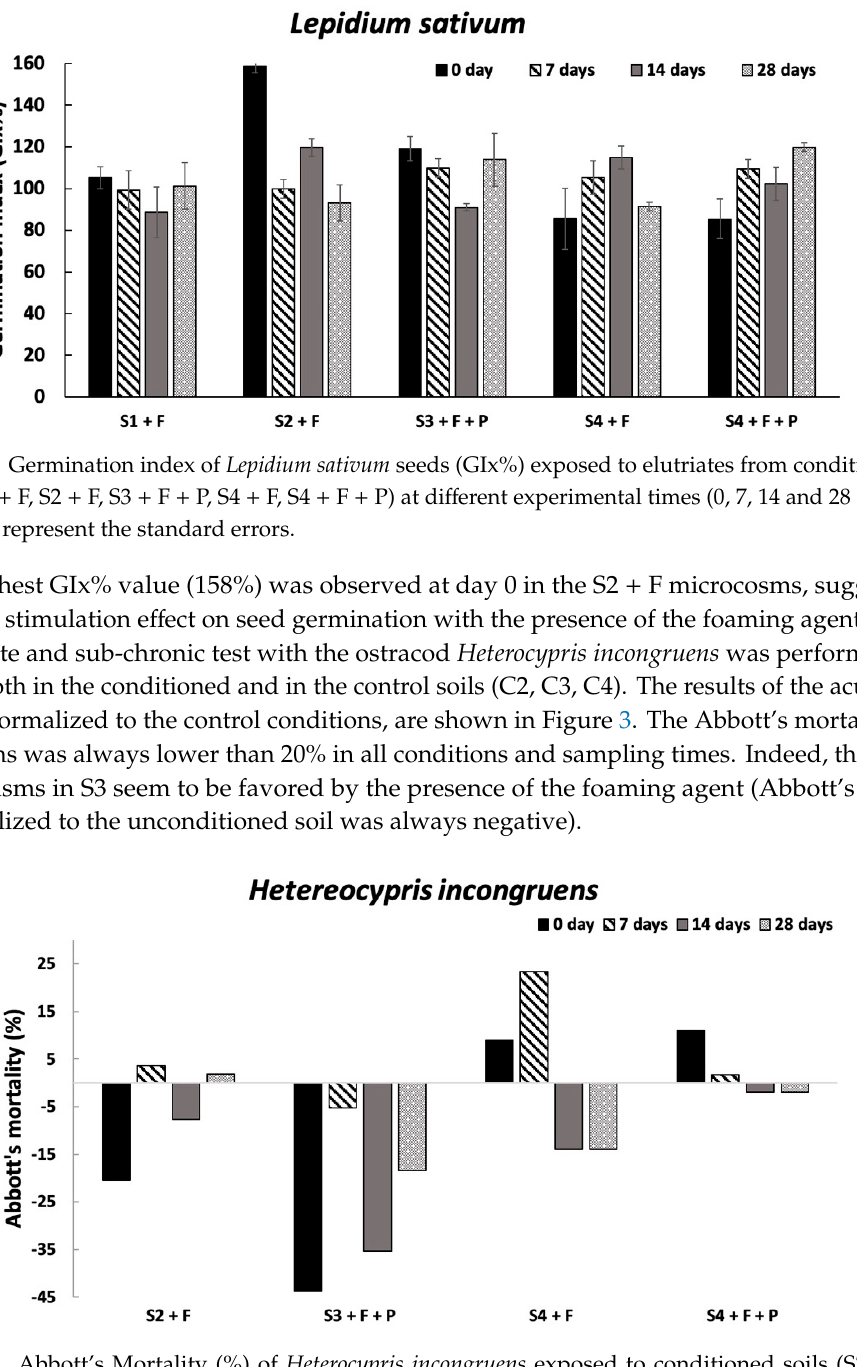
Figure 3. Abbott’s Mortality (%) of Heterocypris incongruens exposed to conditioned soils (S2 + F, S3 + F + P, S4 + F, S4 + F + P) at 0, 7, 14 and 28 days. The data are normalized to the controls (C2, C3, C4).